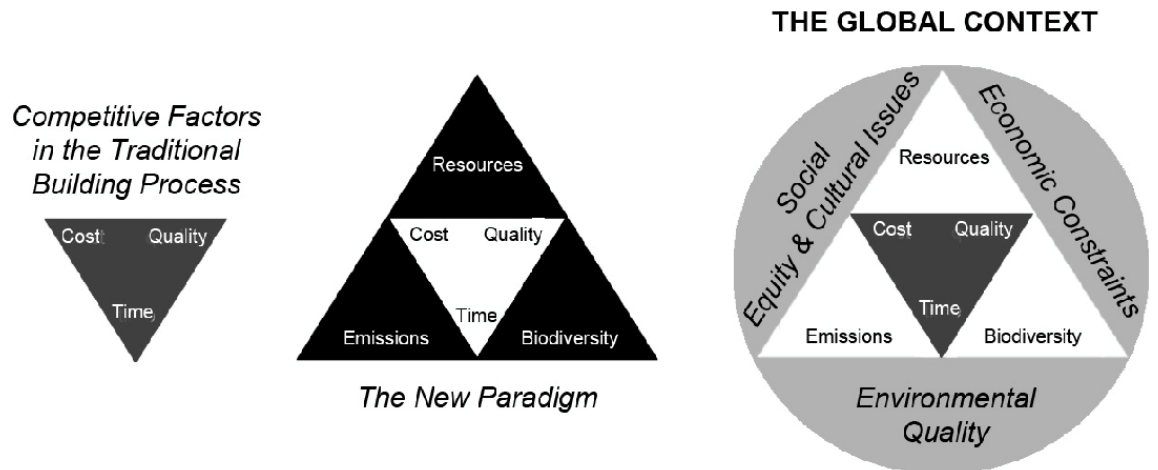
Figure 3. Sustainable construction contextualized from Bourdeau